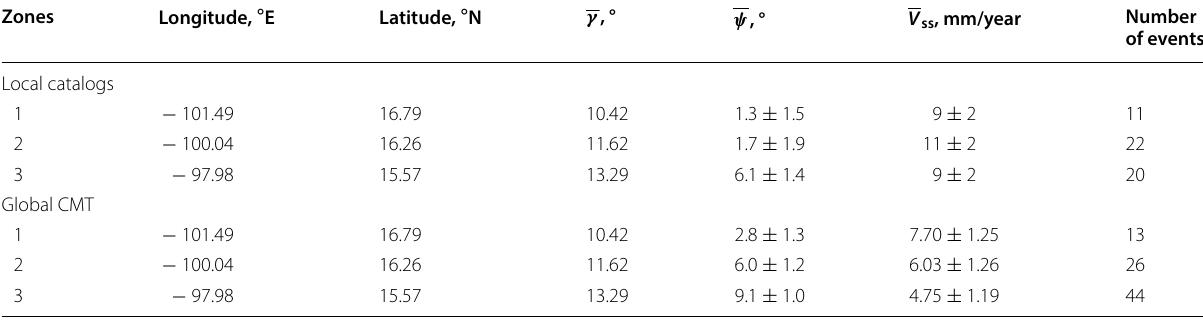
Table 1 Average plate convergence obliquity ( γ ), subduction obliquity ( ψ ) and V ss —sinistral motion of the Xolapa sliver with restect to the fixed NA